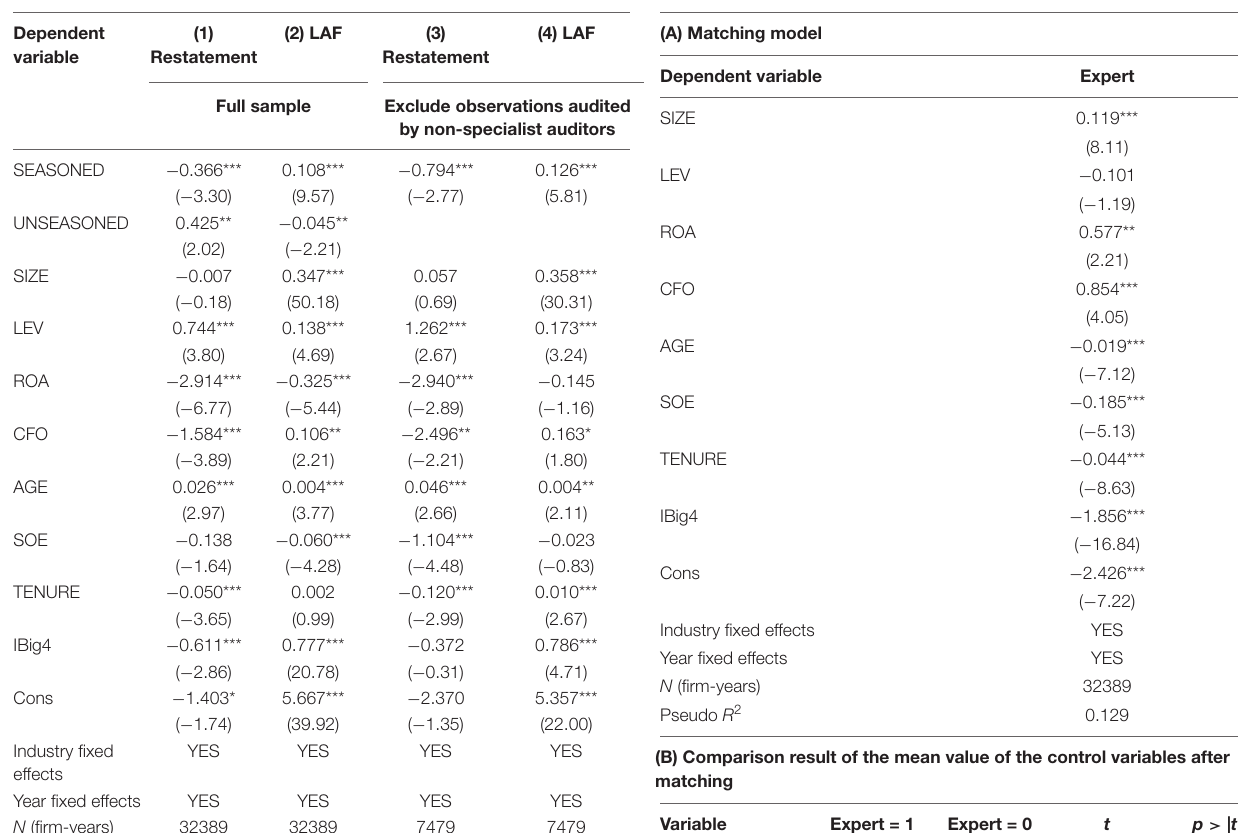
TABLE 3 | Industry specialization, audit quality, and audit fees. TABLE 4 | Propensity score